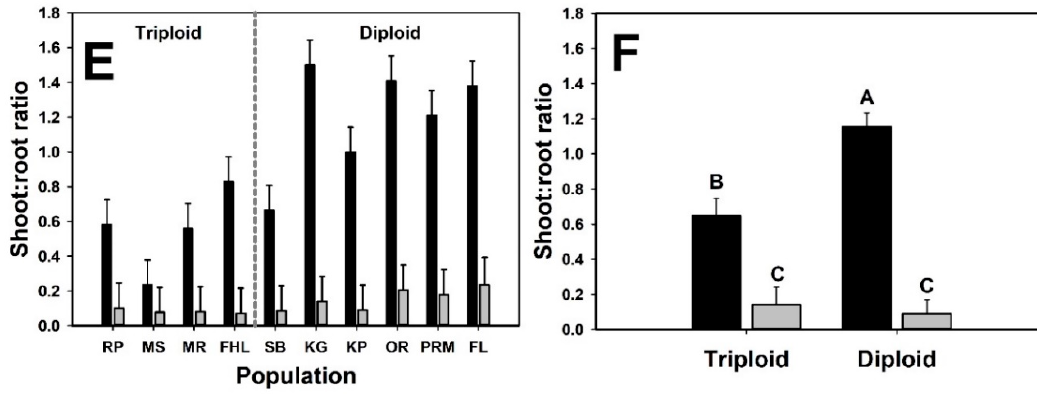
Figure 3. Biomass variables for the emergent interaction experiment. Black bars are mean values for plants growing in monoculture and gray bars are mean values of plants growing in an experimental community. Panels with population means ( A , C , E ) are presented to illustrate variation at the plant level, but statistical results (i.e., means separation) are presented for cytotype means only ( B , D , F ). Letters above bars represent distinct group means designated by Tukey post-hoc comparison.